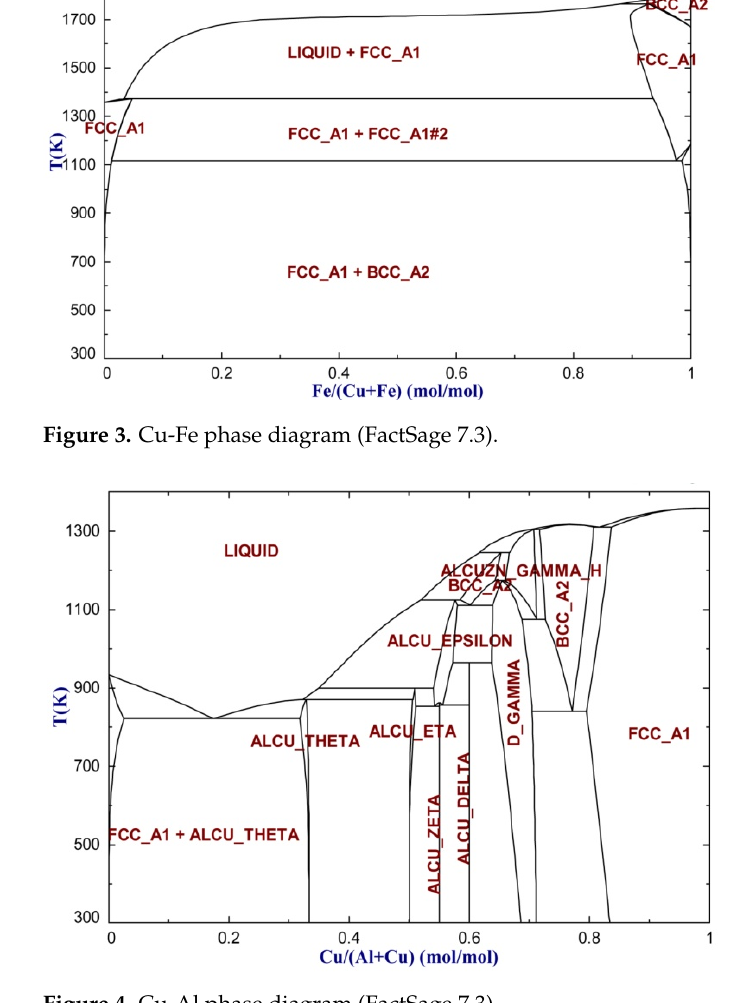
Figure 4. Cu-Al phase diagram (FactSage 7.3).